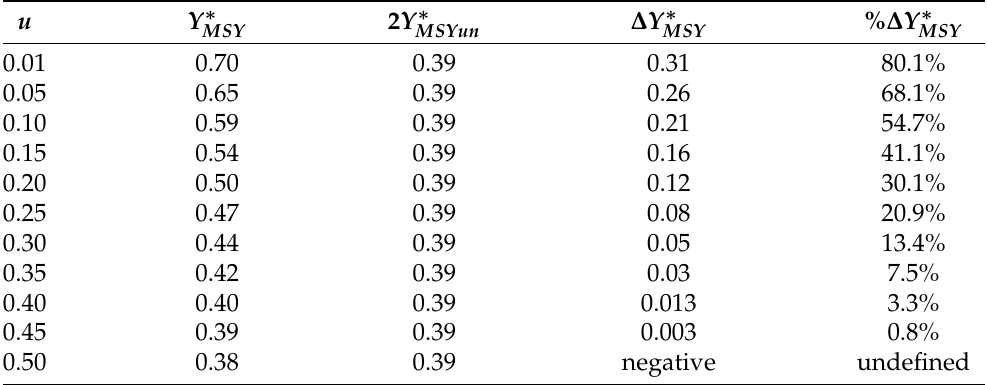
Table 1. Table of yields at MSY: Y ∗ pond 1, with parameter set: µ = 8.5, k = 2.5, s in =